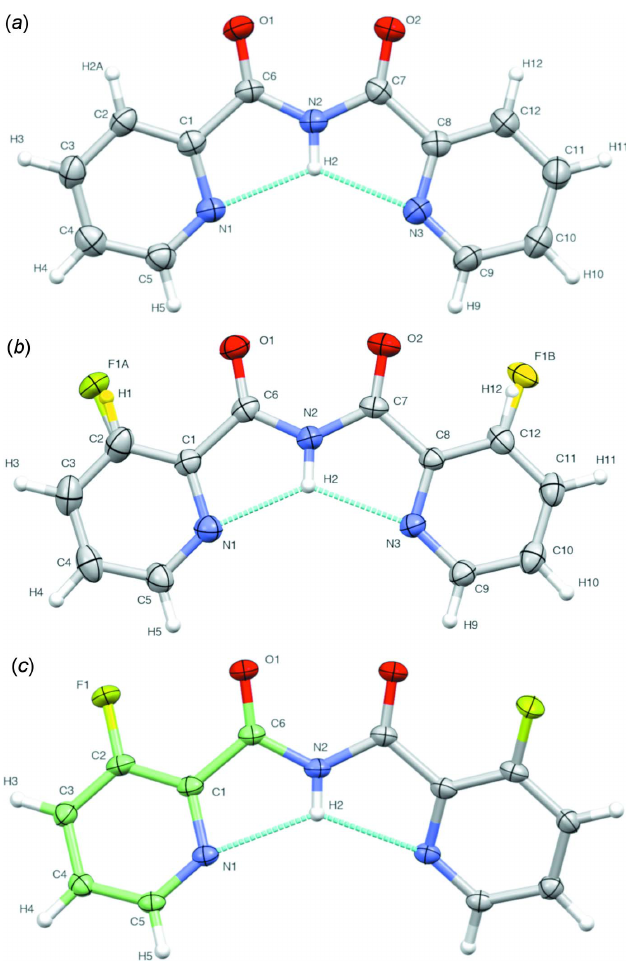
Figure 1 Molecular structures of ( a ) 1 , ( b ) 2 and ( c ) 3 , showing thermal displacement ellipsoids drawn at the 50% probability level and the atom-labelling scheme. The disorder in 2 ( b ) is shown in yellow. The carbon atoms in the asymmetric unit of 3 ( c ) are shown in green. Intramolecular hydrogen bonds are indicated.